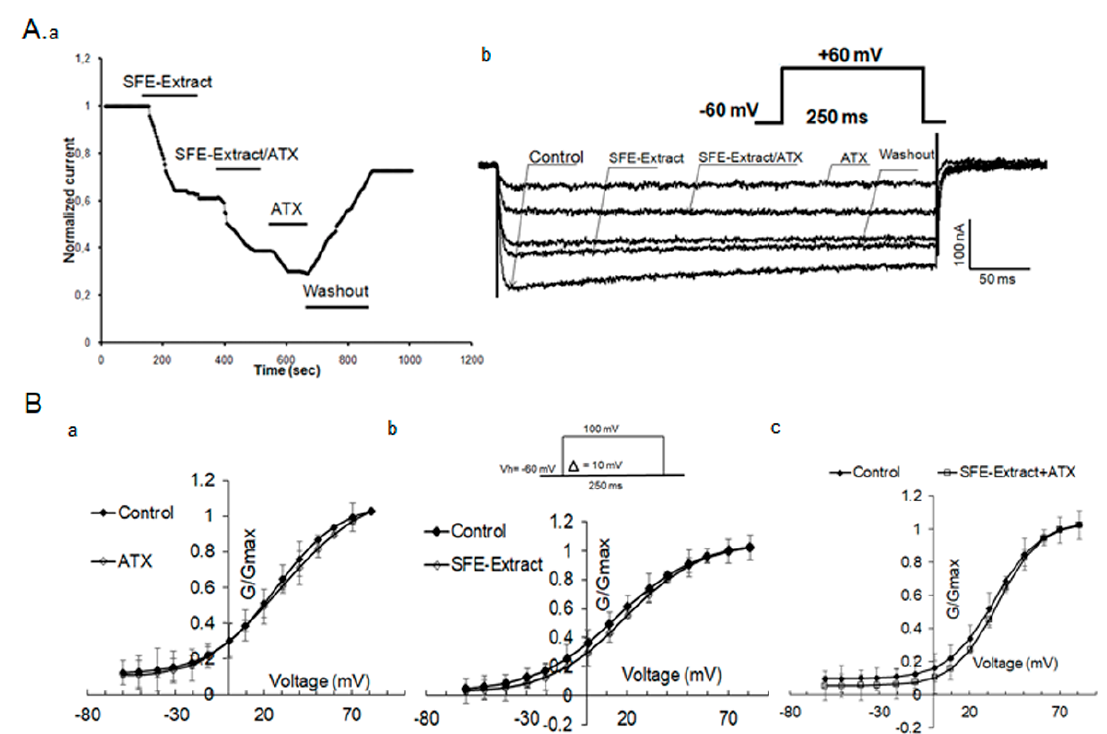
Figure 6. Characterization of ATX and SFE-Extract e ff ects on sodium currents activation in Xenopus oocytes. In (A ) Time course inhibition in the presence of SFE-Extract alone, the extract enriched with ATX, and then the ATX alone. Maximal e ff ect is obtained in the presence of ATX and the washout allows a partial recovery of the current ( a ). Representative traces of xINa recorded at + 60 mV in control conditions and in the presence of SFE-Extract and SFE-Extract enriched with ATX (1 µ g) ( b ). In ( B ) Mean steady state activation curves of xINa in control conditions, in the presence of ATX ( a ) SFE-Extract (10 µ g) ( b ) and SFE-Extract / ATX ( c ). Data are means ± SEM ( n = 4 to 6) and fitted with a standard Boltzmann